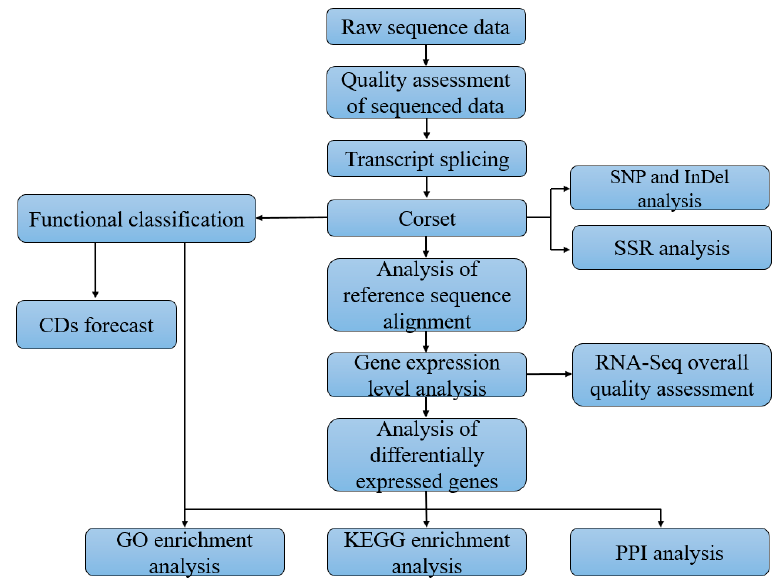
Figure 1. The workflow diagram of RNA-seq data